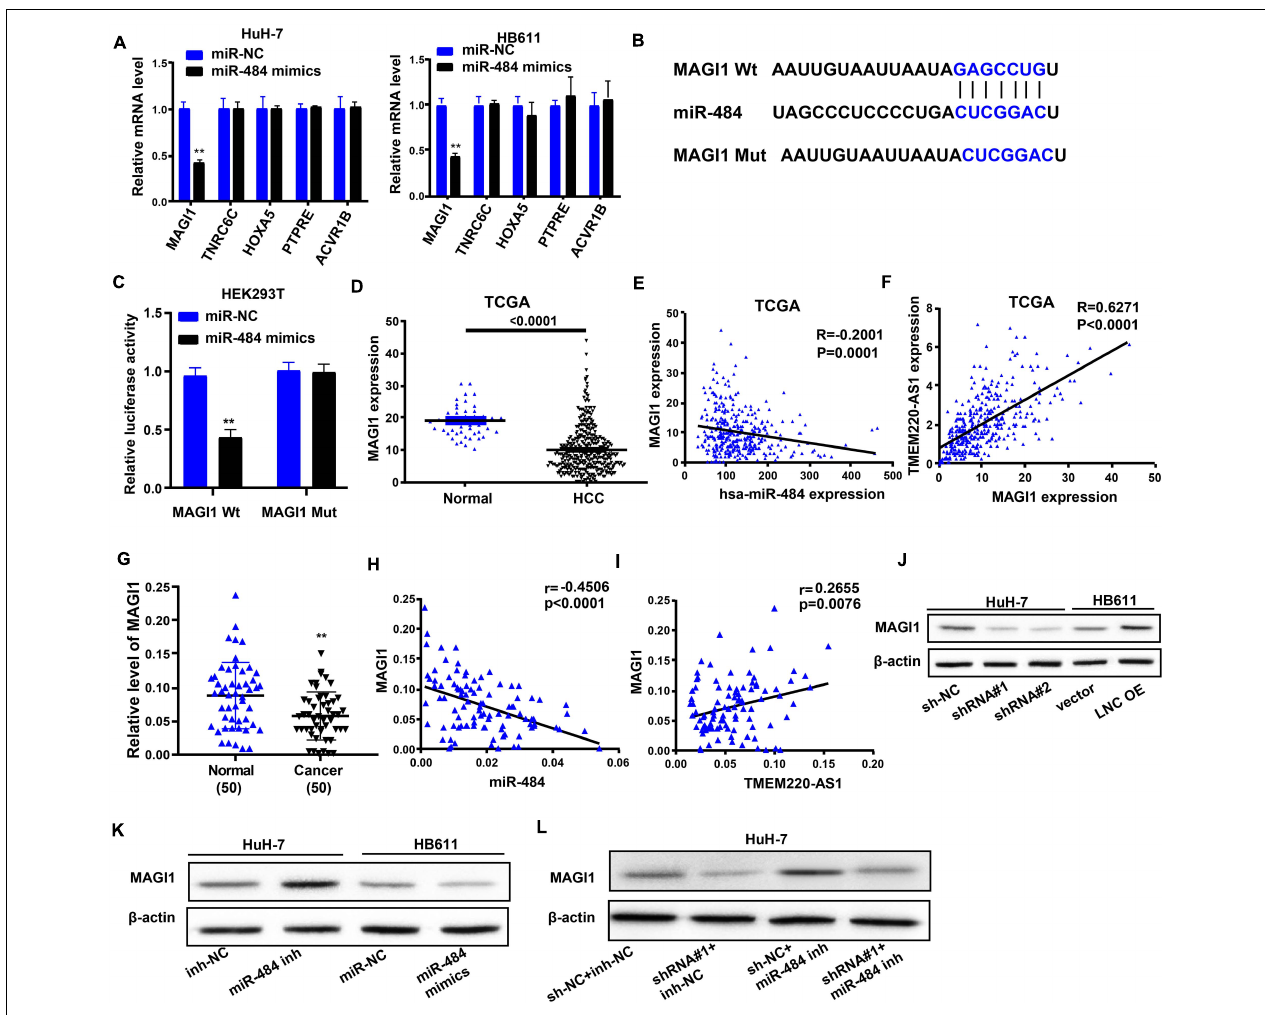
FIGURE 5 | TMEM220-AS1 regulates the miR-484 target gene, MAGI1. (A) The levels of mRNAs after miR-484 cutdown were tested by qRT-PCR. (B) Putative miR-484 binding sequence and mutation sequence of MAGI1 mRNA were as shown. (C) Dual luciferase reporter assays were used to confirm the direct target between MAGI1 and miR-484. (D) MAGI1 gene expression in HCC samples and normal samples, from TCGA database. (E) The correlation analysis between miR-484 expression and MAGI1 expression in HCC samples and normal samples, from TCGA database. (F) The correlation analysis between TMEM220-AS1 expression and MAGI1 expression in HCC samples and normal samples, from TCGA database. (G) MAGI1 gene expression in HCC tissues and paired adjacent normal tissues, from our dataset. (H) The correlation analysis between miR-484 expression and MAGI1 expression in HCC tissues and paired adjacent normal tissues, from our dataset. (I) The correlation analysis between TMEM220-AS1 expression and MAGI1 expression in HCC tissues and paired adjacent normal tissues, from our dataset. (J–L) The level of MAGI1 was detected by western blot assay. Data were presented as represent the mean ± SD; ** P <